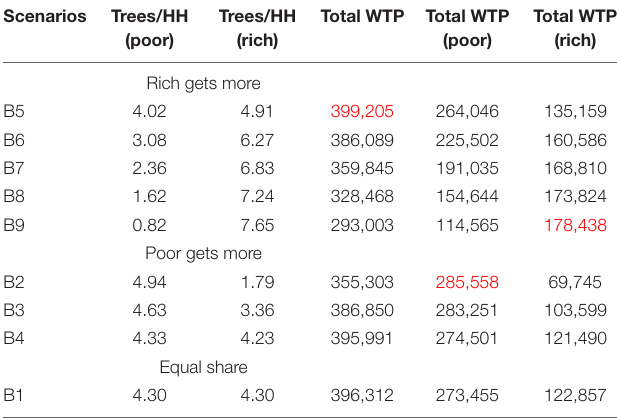
TABLE 6 | Average distribution of trees and total WTP estimates across distributional scenarios. Scenarios Trees/HH